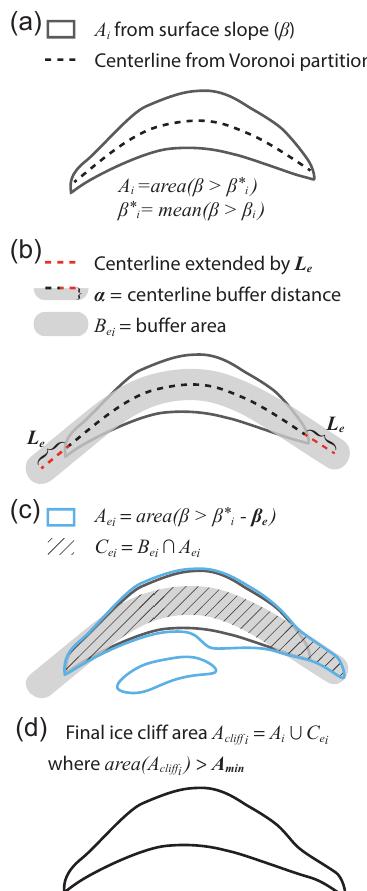
for each itera- Figure 4. Method used to define ice cliff area, A cliff i tion, i , and a final, optimized iteration, subscript opt. Surface slope threshold β i is applied over the range 0–90 ◦ from which the sub- sequent quantities shown in steps a–d are calculated. Quantities in bold font are fixed scalar model parameters that do not vary over the iterative process. Panel (a) shows how the area A i is defined by β ∗ i , the mean surface slope of values constrained by β i . A procedure using a Voronoi partition defines a centerline within A i . Panel (b) shows this centerline extended by a distance of L e , and transformed into an area, B ei , by an outward buffer distance, α , applied in all ( x,y ) directions. Panel (c) shows the definition of A ei , an area de- fined by a surface slope threshold lower than β ∗ i , where β ∗ i is re- duced by β e . The intersection of A ei and the buffer area, B ei , define C ei . C ei allows allow for the identification of ice cliff end area that has a surface slope below β ∗ i and above A ei while rejecting area that falls within the same surface slope interval but is not located at the ends of an ice cliff. The intersection of A i and C ei , with areas below a threshold, A min , removed, defines the final ice cliff area, A cliff , for that i (d) i